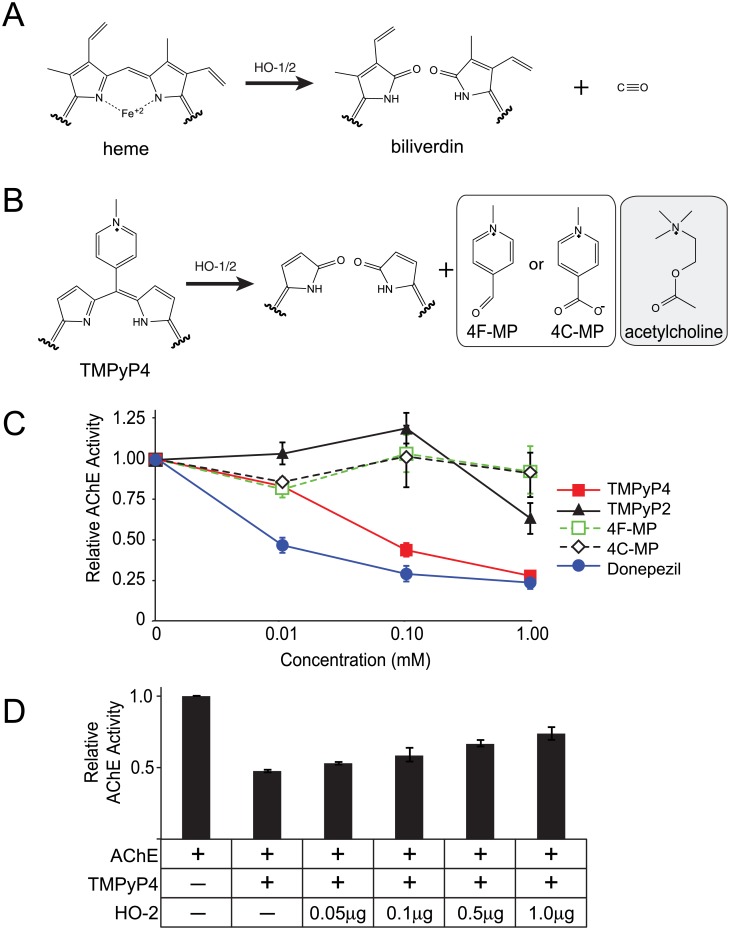
TMPyP4 inhibits AChE activity.
A, oxidation of heme by Hemeoxygenase (HO) enzymes produces biliverdin and carbon monoxide. B, oxidation of TMPyP4 by HO enzymes is expected to generate either 4-formyl-1-methylpyridinium (4F-MP) or 4-carboxy-1-methylpyridinium (4C-MP). Both 4F-MP and 4C-MP have a structural resemblance to acetylcholine. C, fluorometric assay of AChE activity in presence of TMPyP2, TMPyP4, 4F-MP, 4C-MP and an established AChE inhibitor (Donepezil). D, pre-incubation of TMPyP4 with recombinant HO-2 prior rescued AChE activity in a concentration-dependent manner.